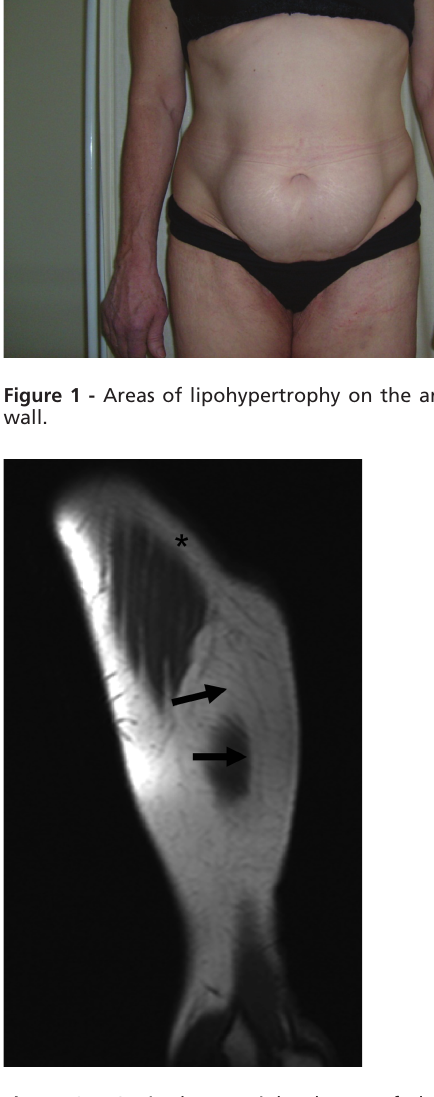
Figure 2 - Sagittal T1 weighted MRI of the left arm shows lipomatous hypertrophy (arrows) at the injection site. Note the normal subcutaneous fat (asterisks) where injections were